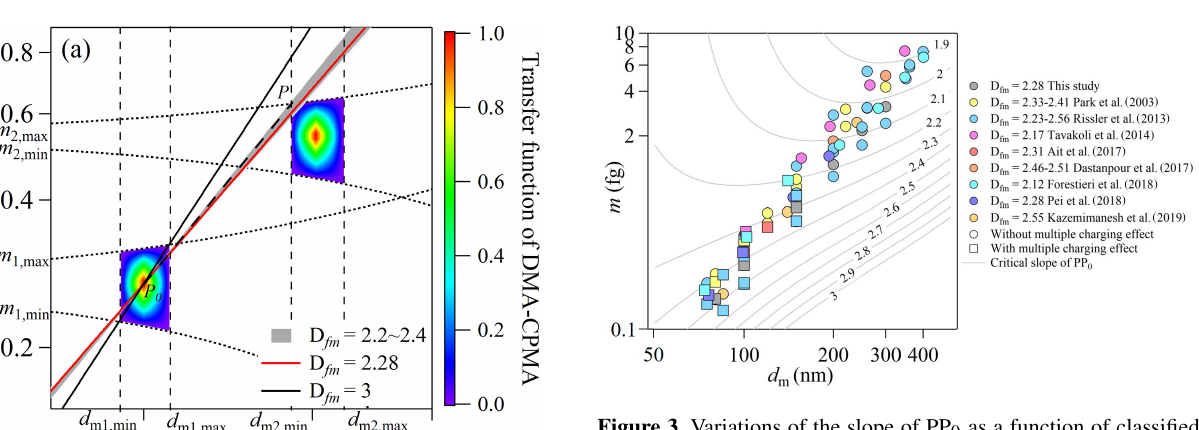
Figure 3. Variations of the slope of PP 0 as a function of classified d m and m . The following parameter set was employed for the cal- culations: β DMA = 0 . 1, Q CPMA = 0 . 3Lmin − 1 and R m = 8. The contour lines denote the critical slope of PP 0 , with values labeled on them. The data points are soot particles measured in the litera- ture (Park et al., 2003; Rissler et al., 2013; Tavakoli et al., 2014; Ait Ali Yahia et al., 2017; Dastanpour et al., 2017; Forestieri et al., 2018; Pei et al., 2018; Kazemimanesh et al., 2019) and generated in this study (see details in Sect. 3.2). The D fm values of these data points are listed in the legend. The data points become square when D fm is smaller than the critical slope of PP 0 in the background; i.e., the potential multiple charging effect may